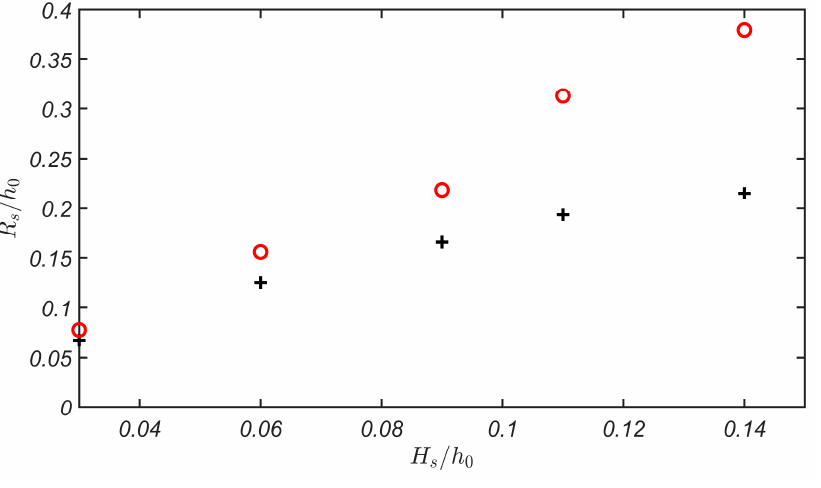
Figure 4. Significant runup height, R s for wide-band (red circles) and narrow-band (black crosses) signals for di ff erent